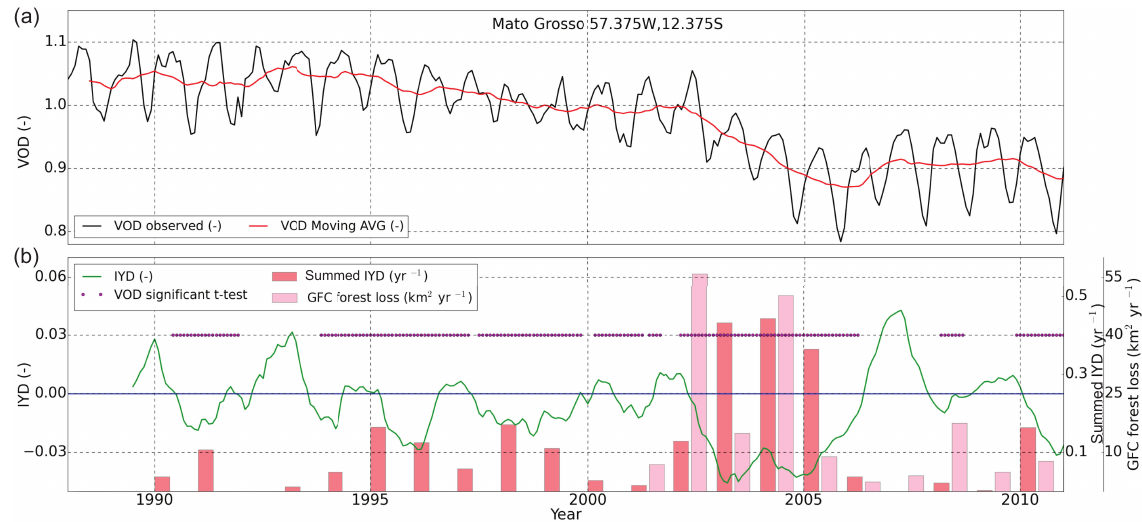
Figure 2. Example 0.25 ◦ grid cell in the Brazilian state of Mato Grosso. A: Observed monthly VOD signal and 19-month moving average (VOD MovingAVG ) . B: Interyearly difference (IYD), whether it met the t test criteria, and annually summed IYD values taking only negative values into account. For comparison the corresponding GFC values are also